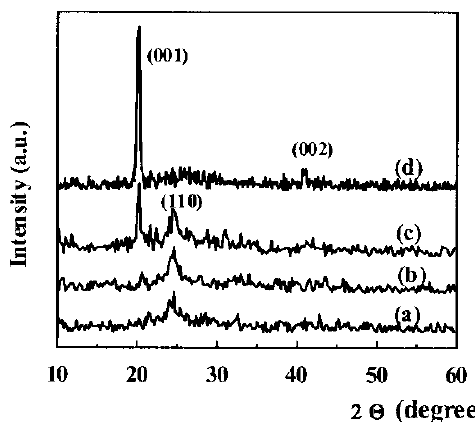
FIGURE 1 XRD spectra for sol–gel 2400rpm spin-coated V 2 O 5 thin films and annealed in air at: (a) 150 (cid:1) C, (b) 200 (cid:1) C, (c) 300 (cid:1) C and (d) 400 (cid:1)